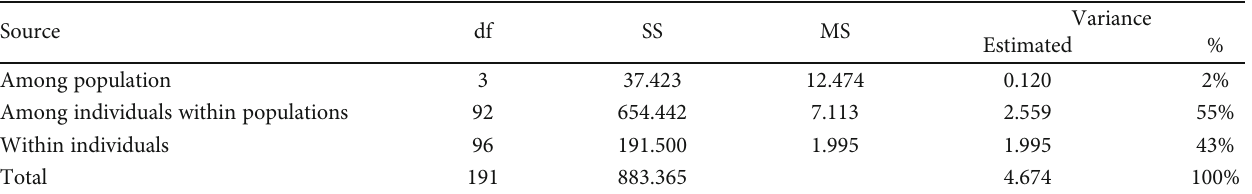
Table 3: AMOVA showing the distribution of genetic diversity within and among populations of Ethiopian O. crenata from di ff erent sources of origins.